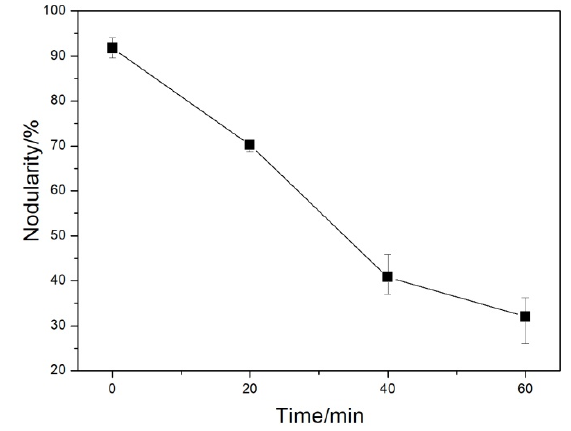
Figure 4. Area fraction of graphite in DI after injecting nitrogen gas for different time periods.